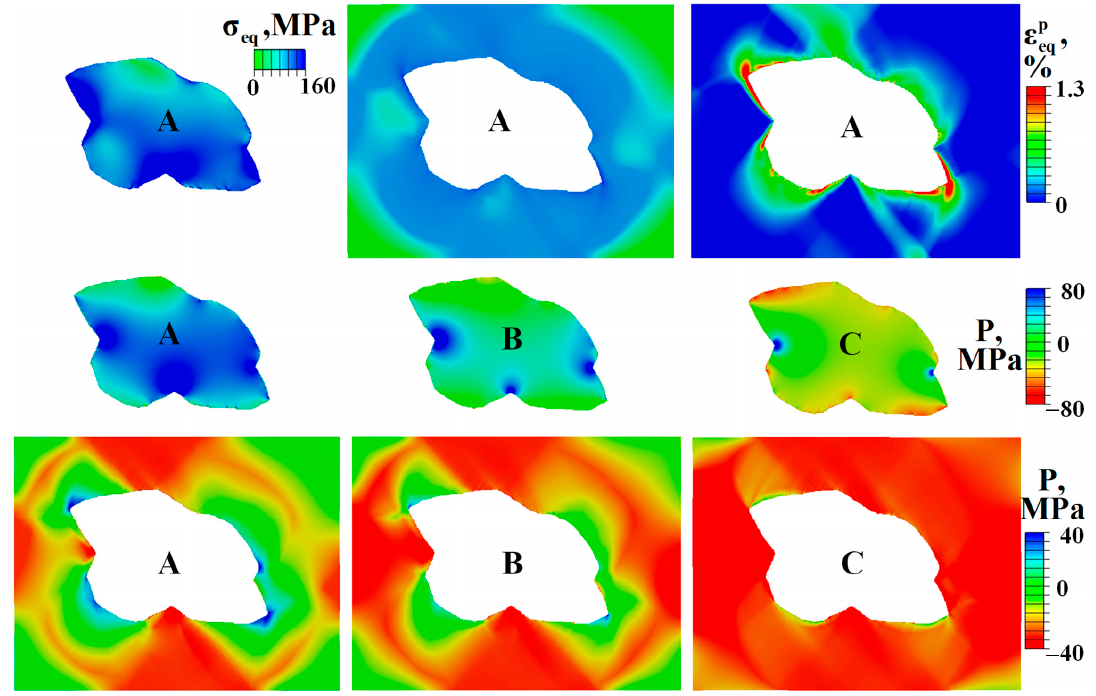
Figure 9. Stress–strain pa tt erns in the Al6061T4-WC composite for states A–C shown in Figures 7 and